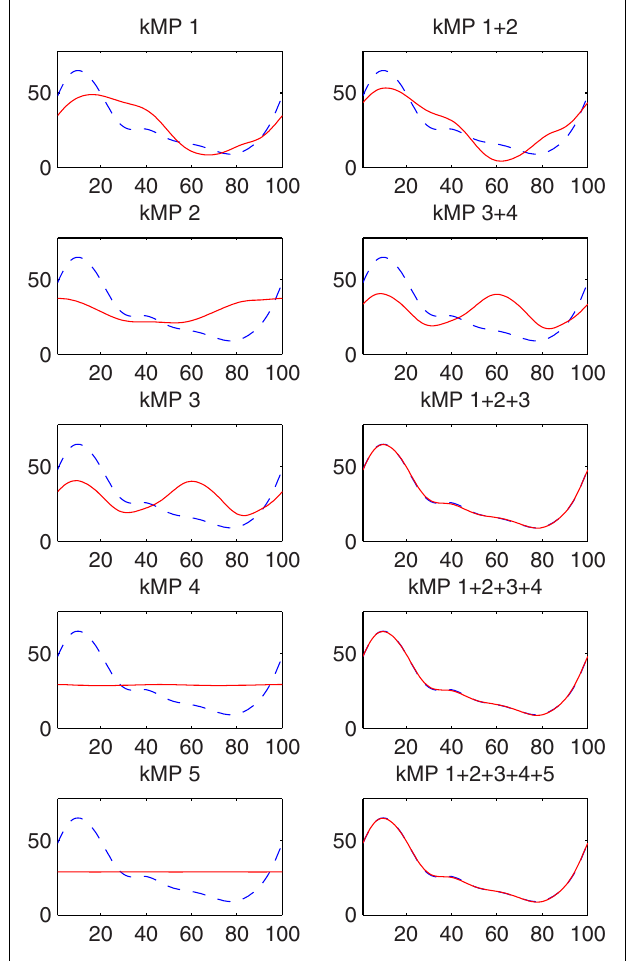
FIGURE 7 | Left knee trajectory generated by reconstruction from kMPs (solid line) compared to the original left knee trajectory (dotted line). On the x-axis the percentage of a gait cycle (from 0 to 100%), and on the y-axis the knee angle in degrees.